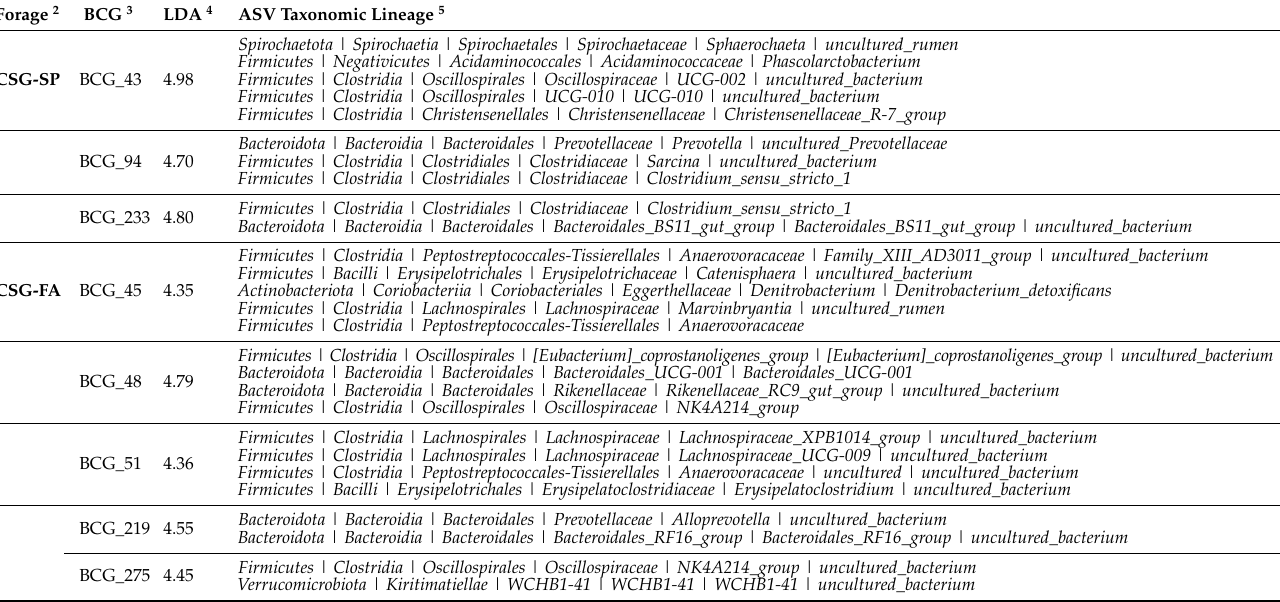
Table 4. Bacterial co-abundance groups (BCG) 1 identified as markers 2 of standardized hay diets.